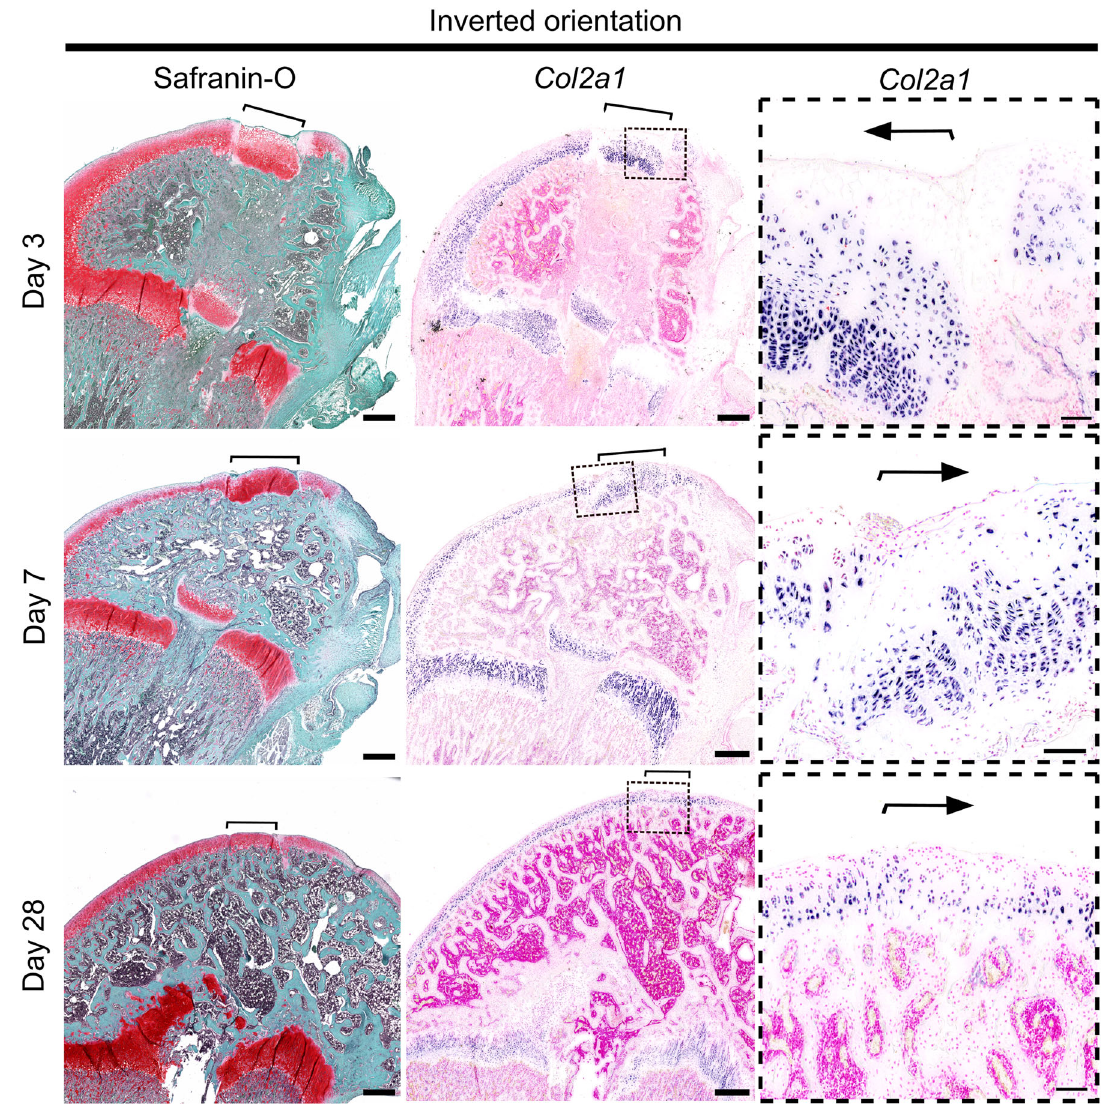
Fig. 5 Proteoglycan content and Col2a1 expression were maintained in transplants inserted in inverted orientation. Osteochondral allografts consisting of articular cartilage, epiphyseal bone, and growth plate cartilage from GFP-expressing rats were transplanted into matching sites in wildtype (GFP-negative) littermate rats in inverted orientation. Proteoglycan content was visualized by Safranin-O-staining (red) in sections of distal femur obtained from transplant recipient rats on postoperative day 3, 7, and 28 and displayed in low power. Expression of chondrocyte marker Col2a1 mRNA was localized by non-radioactive digoxigenin in situ hybridization and displayed in low and high power. Brackets and arrows indicate the location of the transplanted osteochondral allografts. Scale bar: 500 μ m in low and 100 μ m in high-power